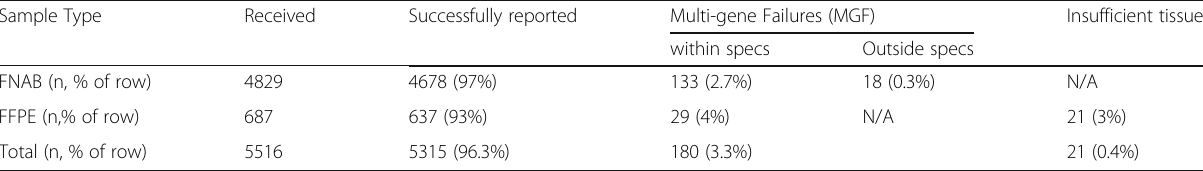
Table 2 Clinical experience of DecisionDx-UM testing Sample